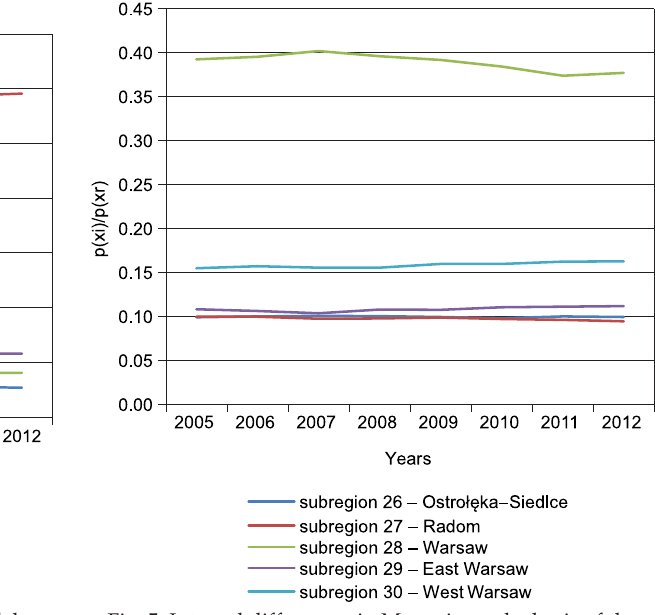
Fig. 4. Internal differences in Mazovia on the basis of the probability of income generated in the years 2005–2012